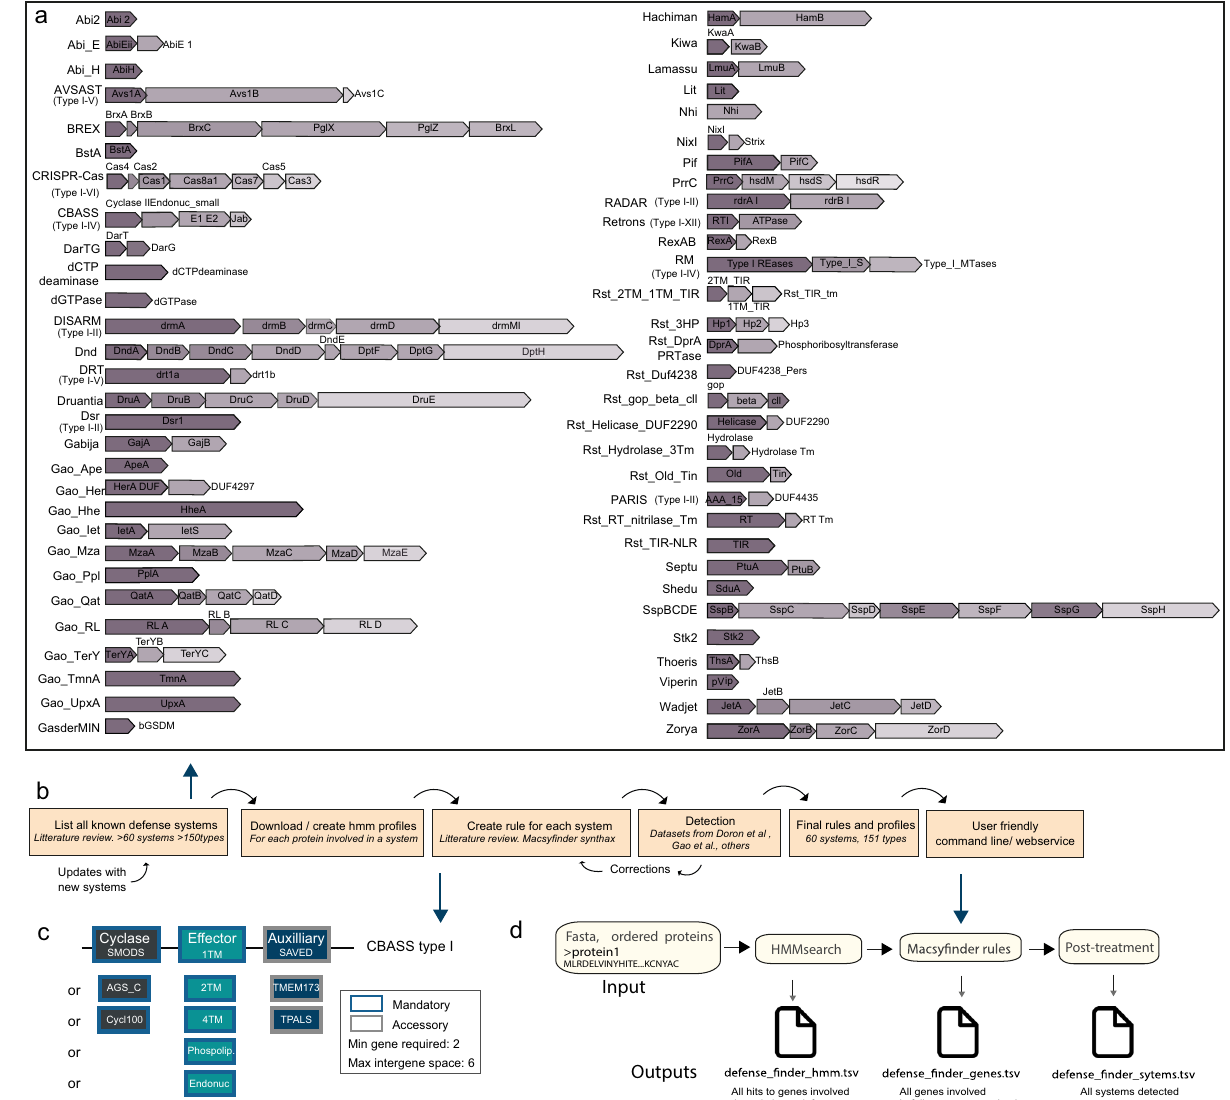
Final rules and profiles 60 systems, 151 types